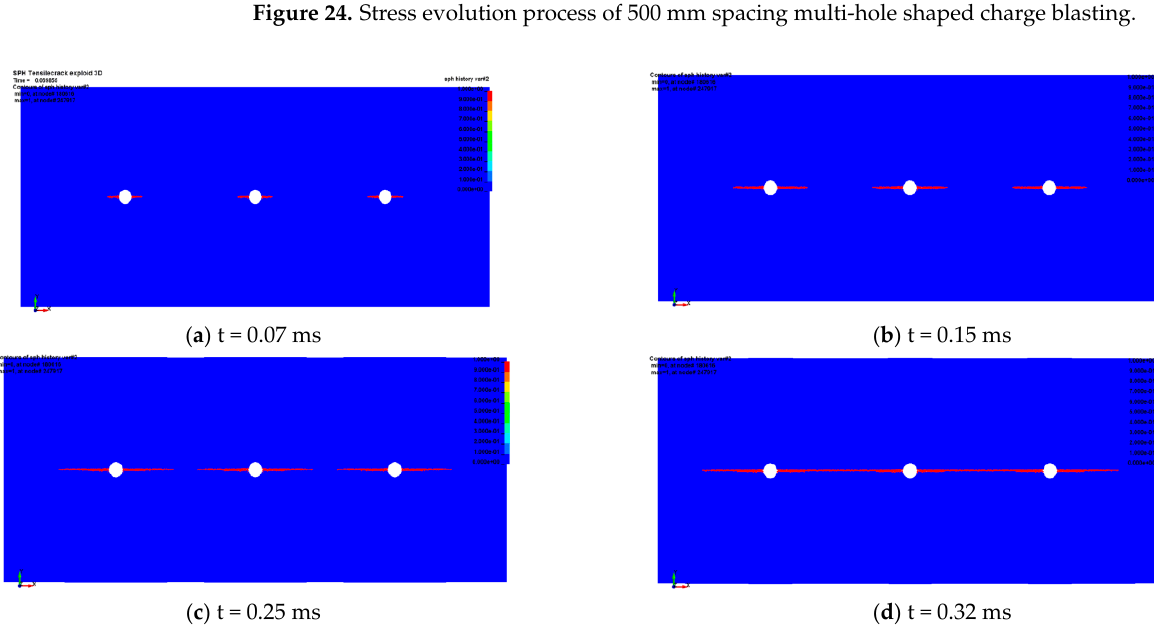
Figure 25. Development process of cracks caused by multi-hole blasting with 500 mm spacing.